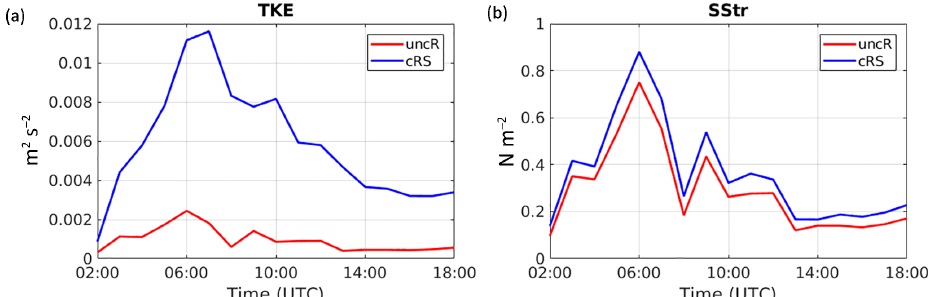
Figure 9. Time series comparison of the TKE (a) and SStr (b) obtained from the results of the uncR (in red) and cRS run (in blue) at P3 during the wind-jet E3 event (25 April